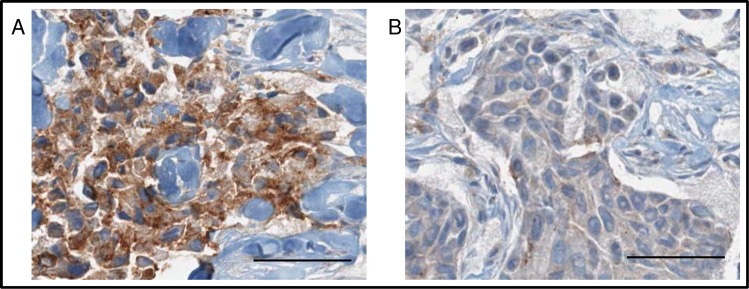
Representative immunostaining of breast tumors with claudin 1 antibody.A human breast tumor exhibiting high (A; tumor #11) and one exhibiting low (B; Tumor #3) levels of the claudin 1 protein. Scale bars = 60 μm.